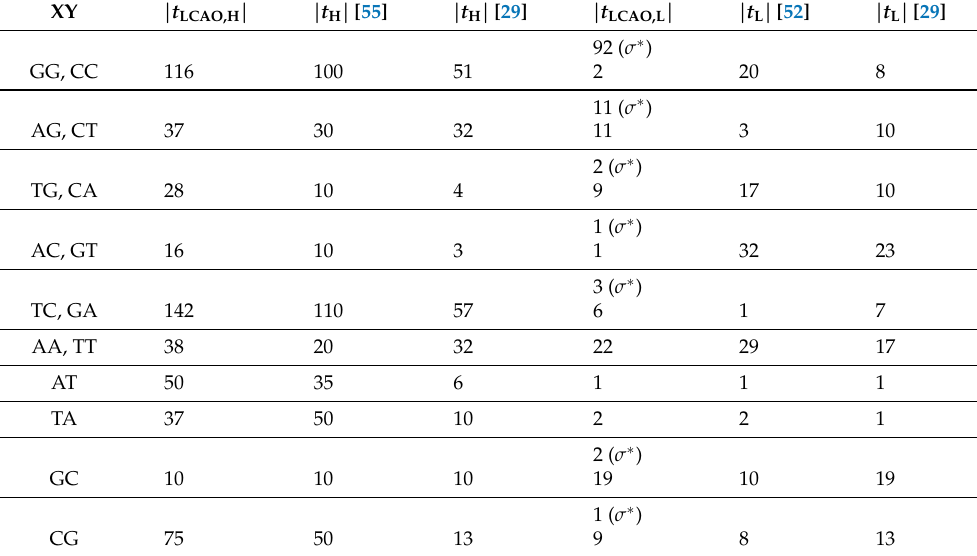
Figure 7. Occupation probabilities of each atomic orbital, | c i ν | 2 (cf. Equation (1)), for the HOMO ( left ) and LUMO ( right ) states of G and C bases into a G-C base pair ( top ), along with the corresponding probabilities (cf. Equation (12)) for the HOMO and LUMO states of the G-C base pair ( bottom ). Table 6. Close-to-ideal geometrical conformations. The absolute values of transfer parameters for all possible combinations of successive base pairs. | t LCAO,H | ( | t LCAO,L | ) of the second (fifth) column refer to hole (electron) transfer parameters obtained from our LCAO calculations using all valence orbitals. The third column lists hole transfer parameters of Reference [55], an estimation from various articles found in bibliography. The sixth column lists the electron transfer parameters of Reference [52], where only 2p z orbitals had been used. The fourth and seventh columns list the transfer parameters with the parameterization of Reference [29], where only 2p z orbitals had been used. All transfer parameters are given in